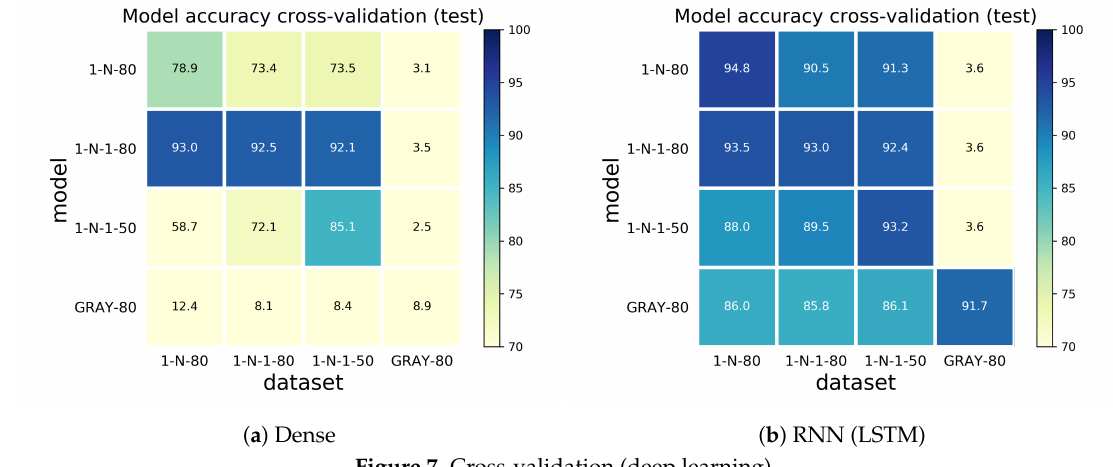
Figure 7. Cross-validation (deep